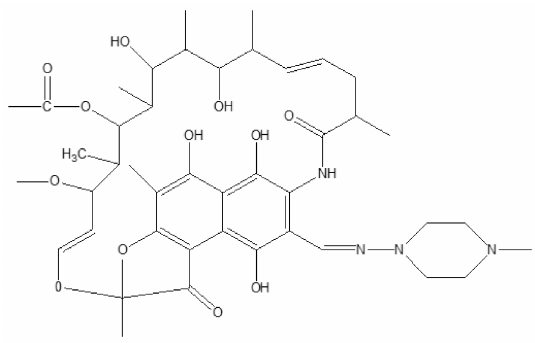
Figure 1. Chemical structure of